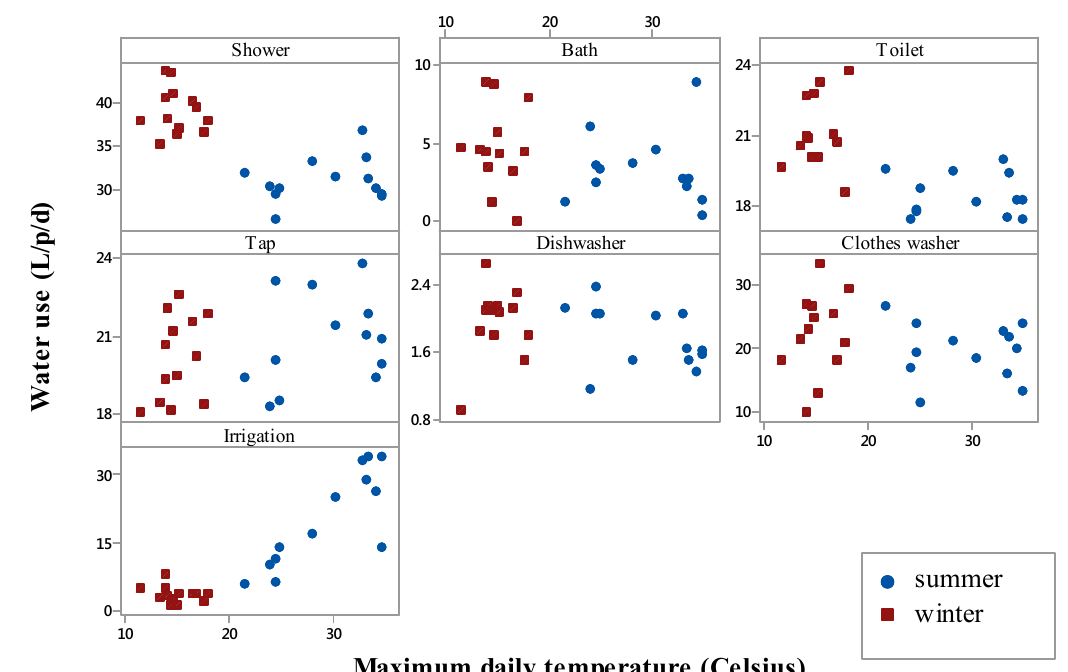
Figure 1. Scatter plots of seasonal water end-use volume and maximum daily temperature categorised by season for YVW